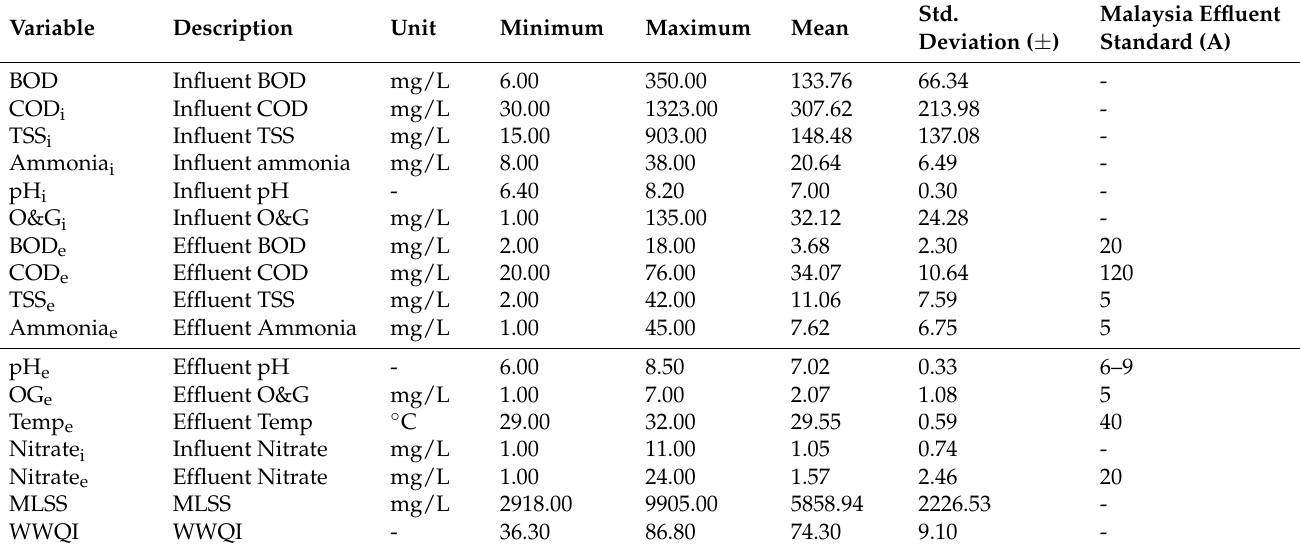
Table 1. Variables used for